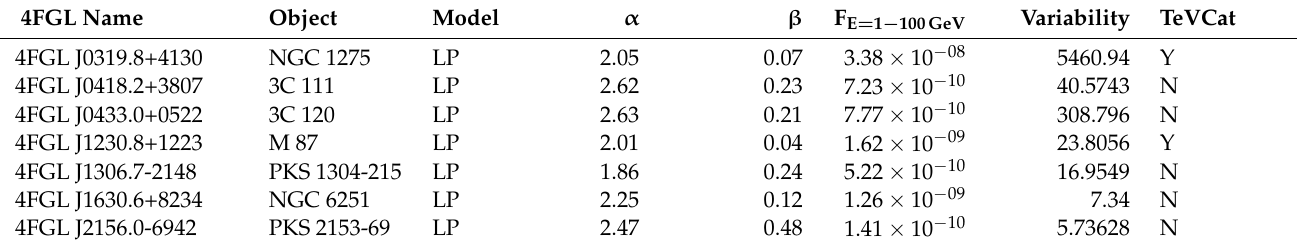
Table 2. The Fermi -LAT 4FGL-DR3 radio galaxies, sorted by right ascension, that exhibit SEDs best fitted with a log-parabola model. The columns include the 4FGL catalogue name, an alternative object name, the type of model best fitted to the SED where LP is for log-parabola, the log-parabola spectral index value ( α ), the log-parabola spectral curvature value ( β ), the photon flux